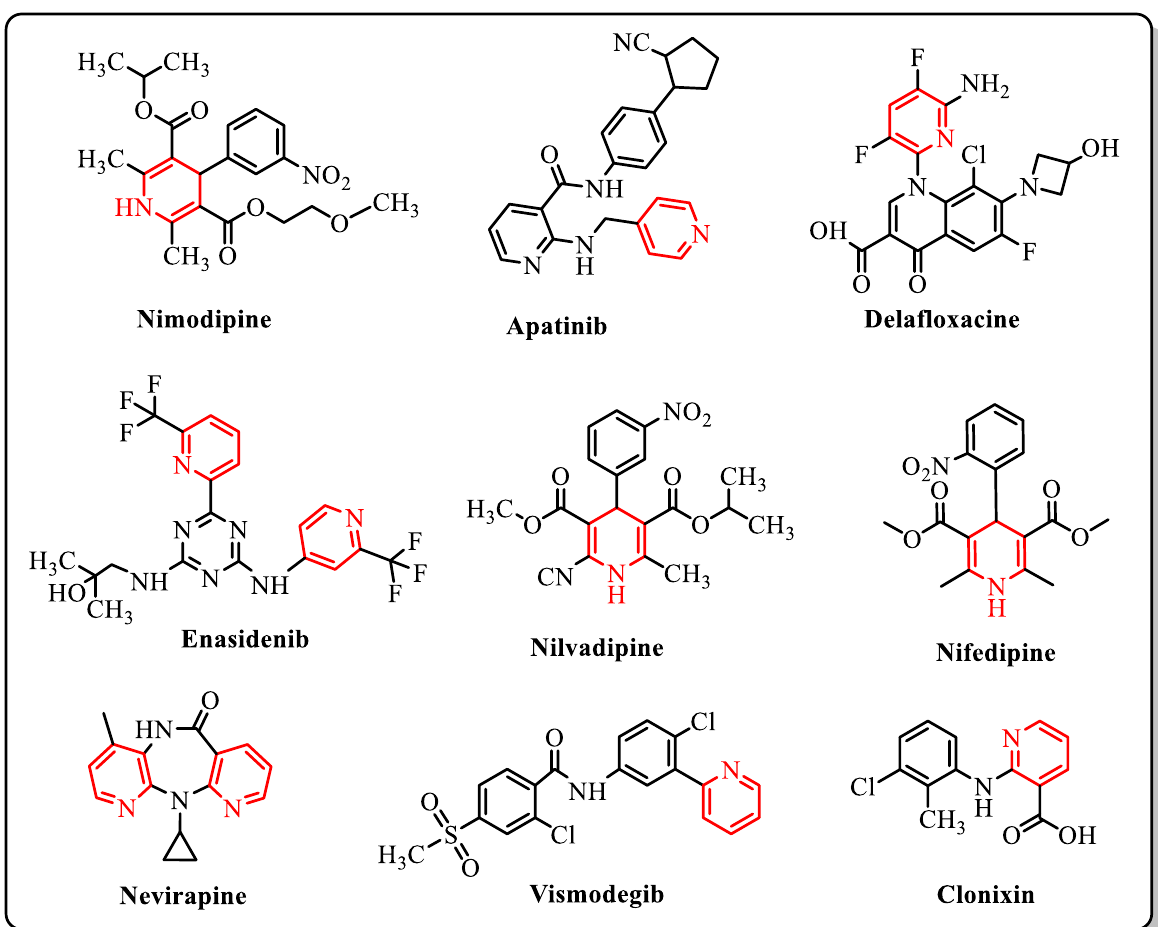
Figure 1. Pyridine- and dihydropyridine-based FDA-approved market drugs.